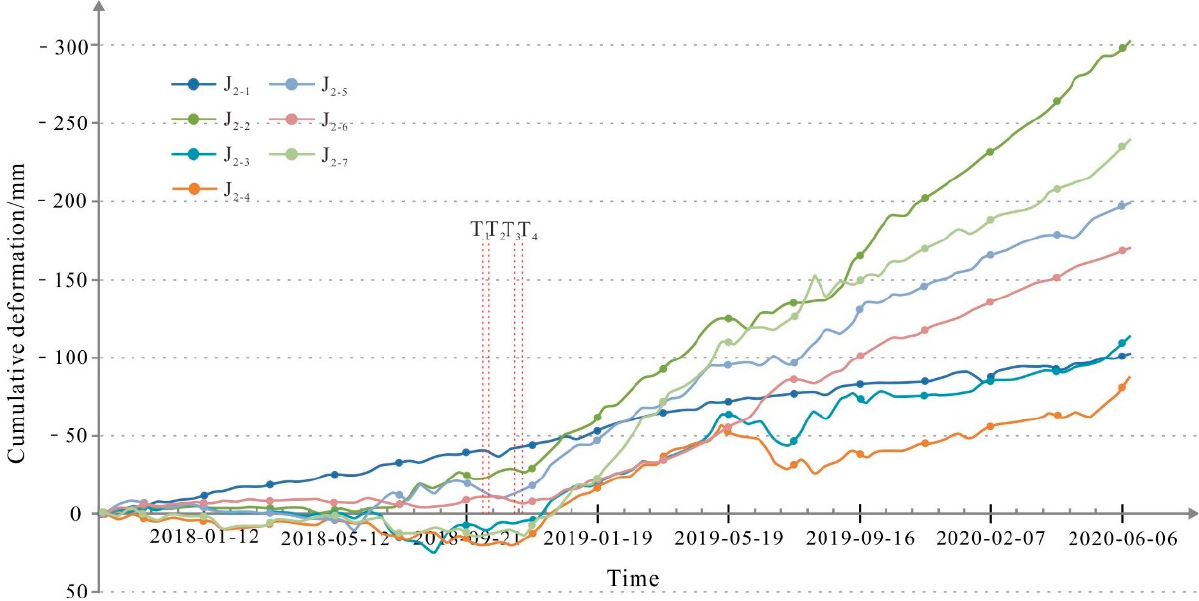
Figure 13. Time series deformation curve of characteristic section B-B’ of the H 1 deformation body from October 2017 to June 2020. T 1 —10 October 2018; T 2 —12 October 2018; T 3 —3 November 2018; T4—12 November